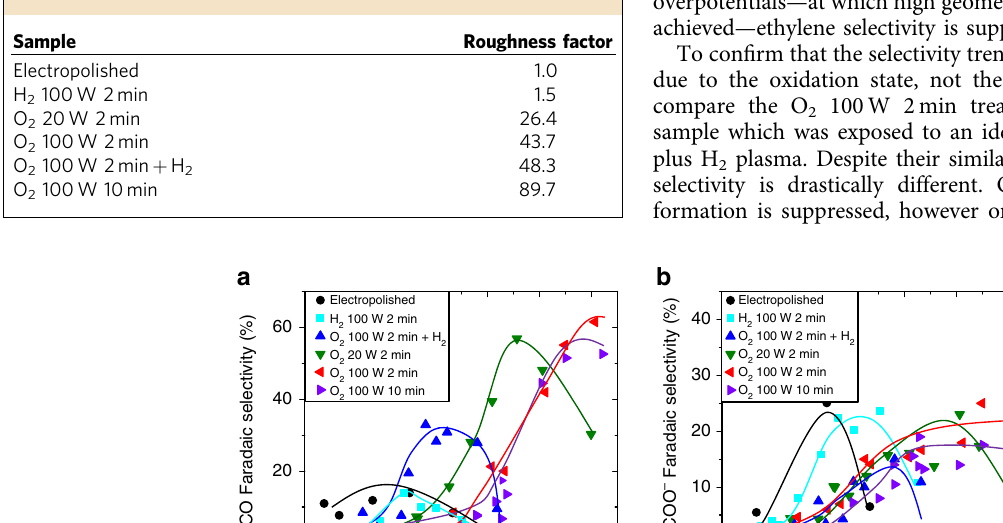
Table 1 | Roughness factors estimated through capacitance